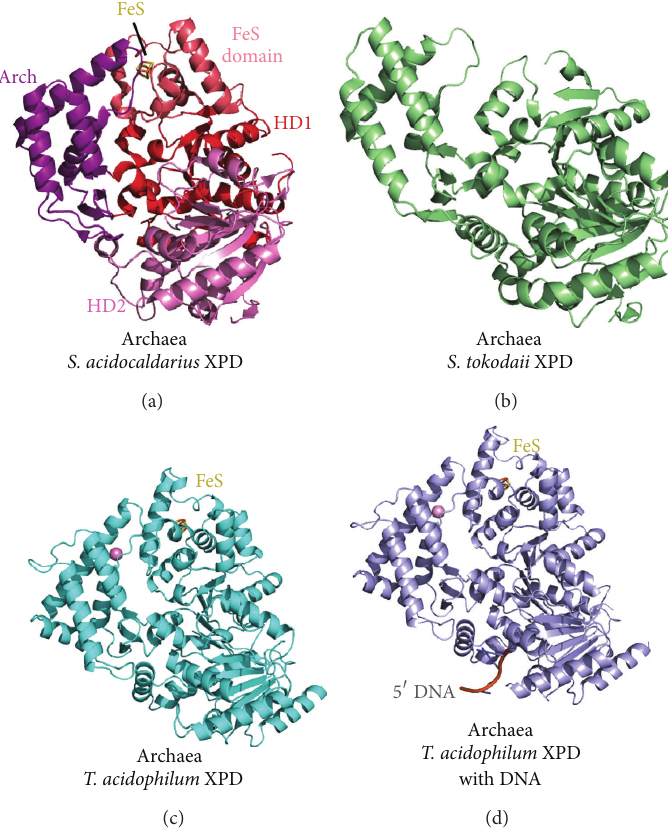
Figure 4: Insights into XPD from archaeal structures. Structures of XPDs from S. acidocaldarius (PDB code 3CRV), S. tokodaii (PDB code 2VL7), and T. acidophilum XPD with (PDB code 4A15) and without DNA (PDB code 2VSF) reveal Arch, Fe-S, HD1, and HD2 domains forming a seat-shaped molecule. Notably, despite similar architecture, cleft pore size between Arch and Fe-S domains varies, suggesting flexibility in this region. DNA orientation is shown for T. acidophilum XPD, and a calcium ion is shown as a pink